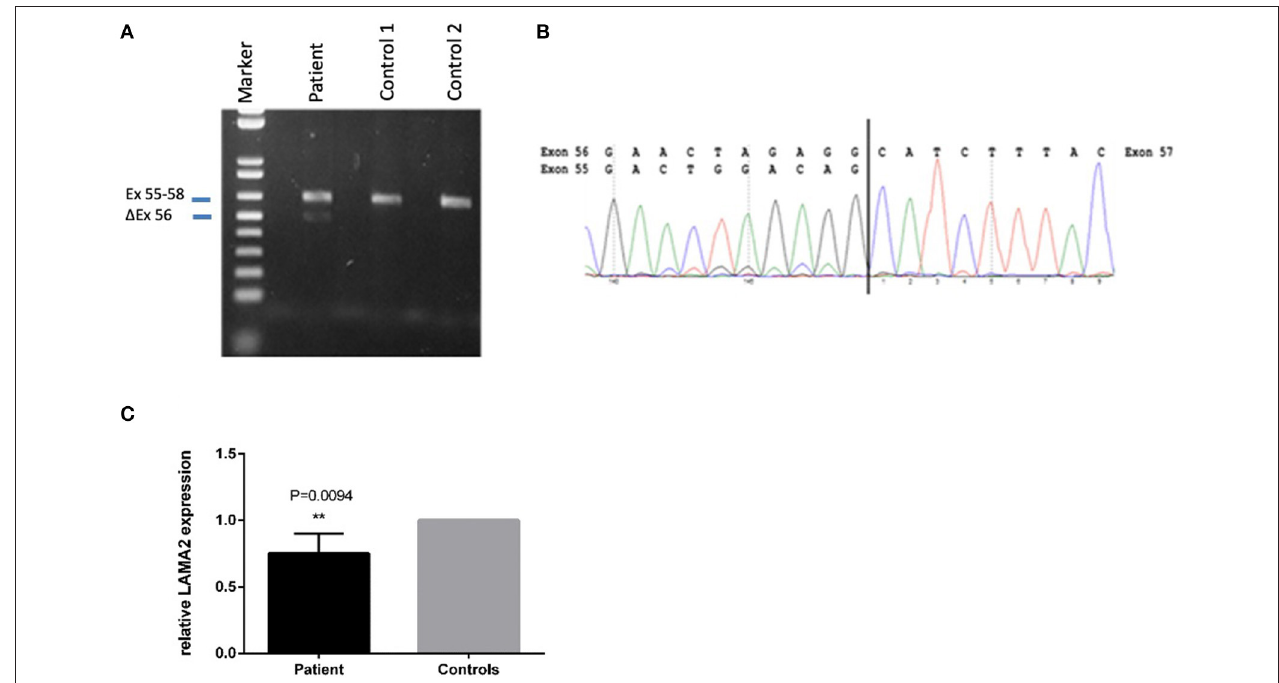
FIGURE 3 | Sequencing of the LAMA2 RNA from patients‘ blood revealed partial exon-skipping of exon 56. (A) Proof of partial exon skipping of exon 56 on cDNA from patients’ blood compared to two control samples. Upper band 629 bp (corresponding to the estimated size of exon 55–58), lower band 480 bp (corresponding to the estimated size of exon 56 skipping). (B) mRNA base sequence of the patient from exon 55 to 57. (C) Quantitative RT-PCR on patients cDNA in comparison to three wild type controls in three biological replicates. PPIA and GAPDH were used as housekeepers. The relative LAMA2 expression was calculated using the ddCT method. A significant lower expression of the LAMA2 transcript was observed (**p < 0.01), demonstrating a partial non-sense mediated decay